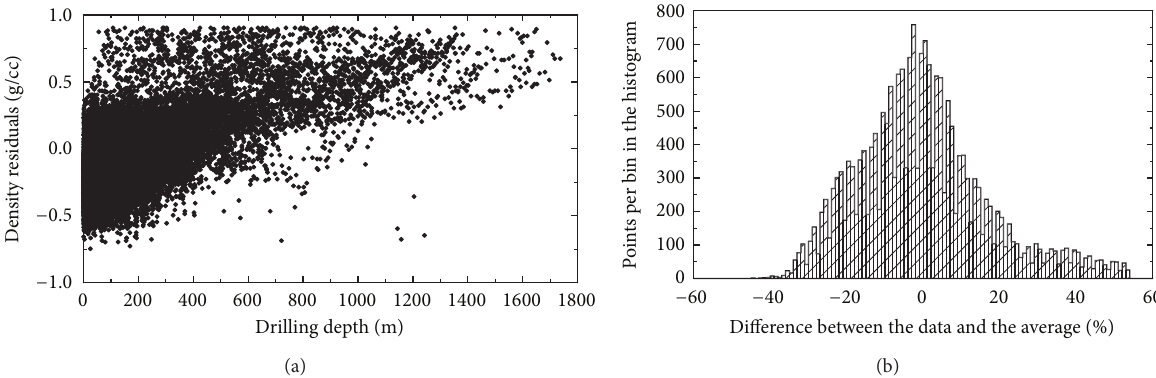
Figure 8: Errors of a uniform density distribution model. Scatter plot and histogram of the differences between the measured densities and the average sediment density of 1.70g/cm 3 . Statistics of the differences: standard deviation = 0.29 g/cm 3 , max = 0.90 g/cm 3 , and min = − 0.75 g/cm 3 . The histogram shows the relative distribution of density differences.